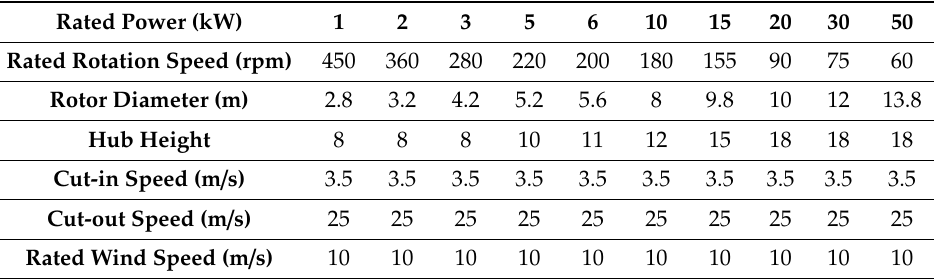
Figure 2. Wind lens turbine [40]. Table 4. Specifications of selected small wind turbines.